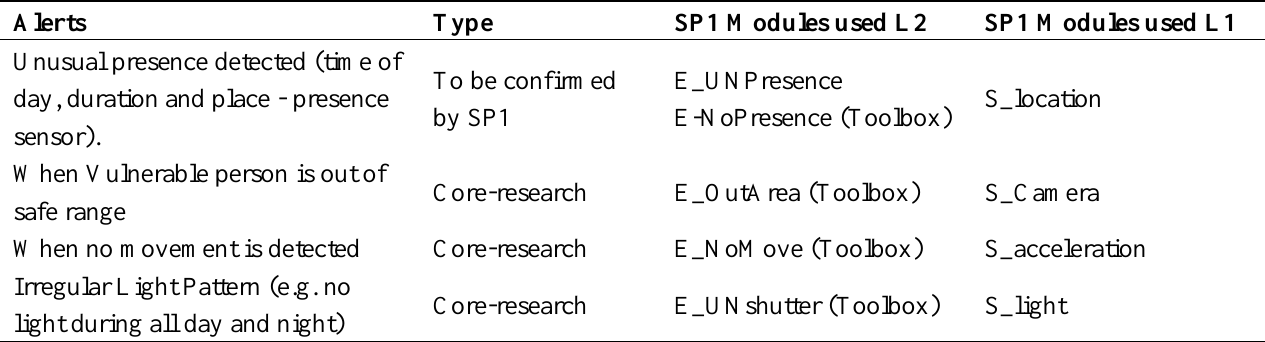
Table 3. Service description decomposing in framework layers the needed components.